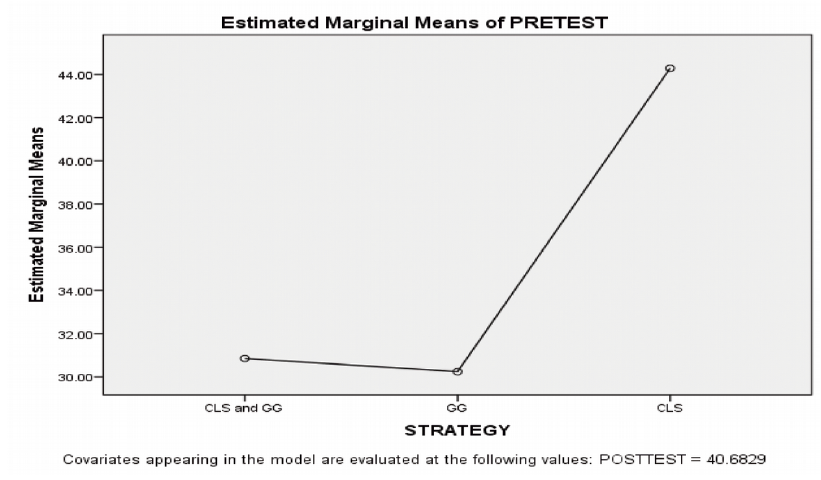
Figure 5. Pre-test estimated marginal means